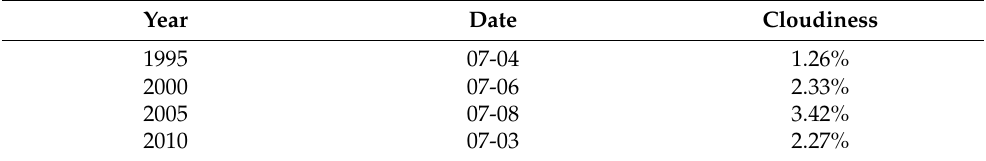
Table 2. Introduction of data information.